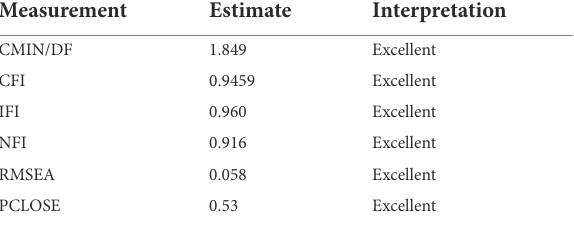
TABLE 2 Model fit criteria.